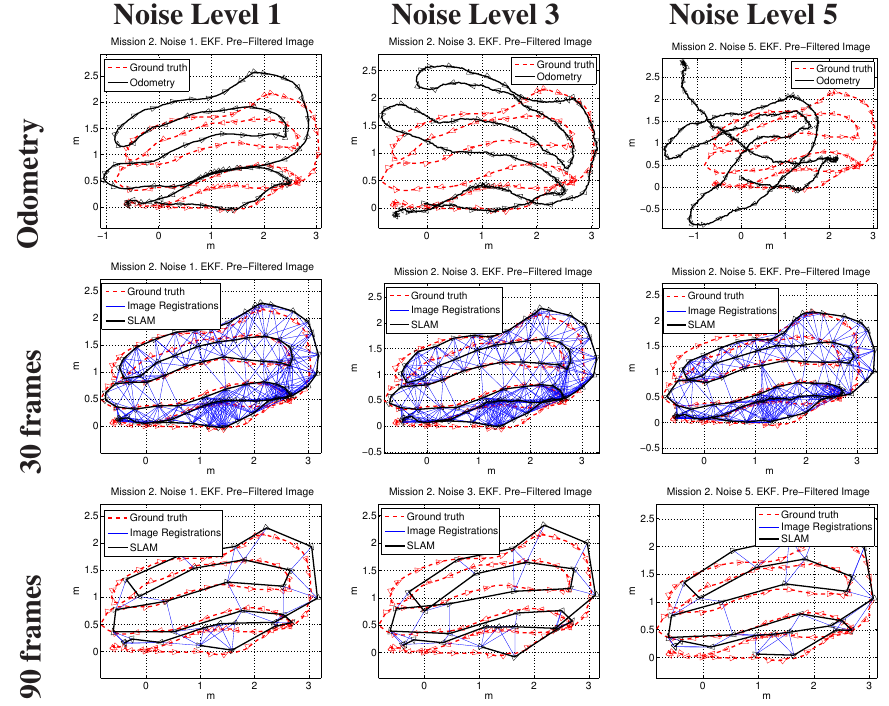
Figure 15. Example results corresponding to the second mission. The first row compares visual odometry and ground truth. The next rows correspond to different keyframe separations. The first, second and third columns are related to Noise Levels 1, 3 and 5,